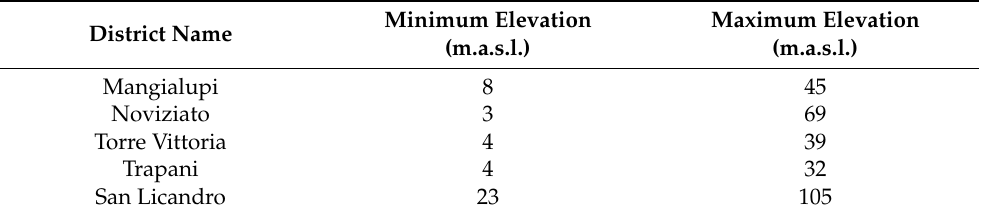
Table 1. Elevation Values (minimum and maximum) of supply junctions for each of the five main districts identified after partitioning.